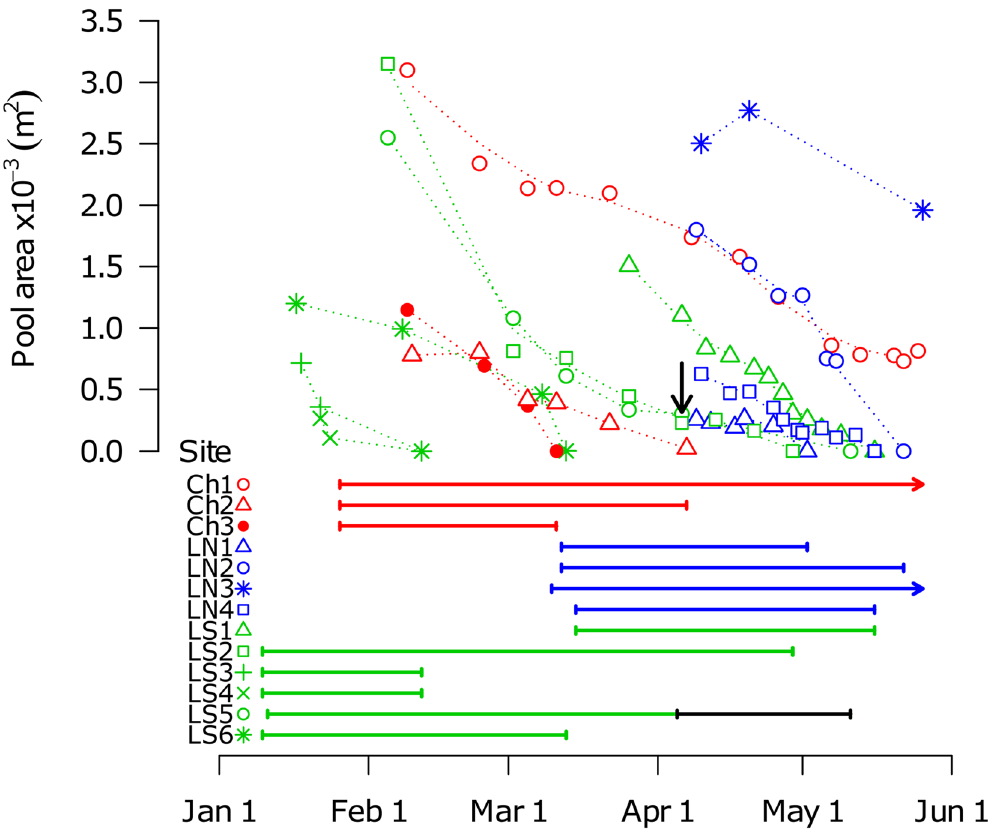
Figure 2. Pool area of the study sites throughout the 2016 rainy season. The points denote pool area when visited and the smooth dashed lines are fitted using LOESS function. The zero pool area marks the date when the pool was found to be dry. The black arrow shows a moment when fish disappeared from the pool LS5, while water was still present. The site-specific full lines show period between hatching and either pool desiccation, fish disappearance (site LS5, with the black line for period without fish), or termination of the fieldwork